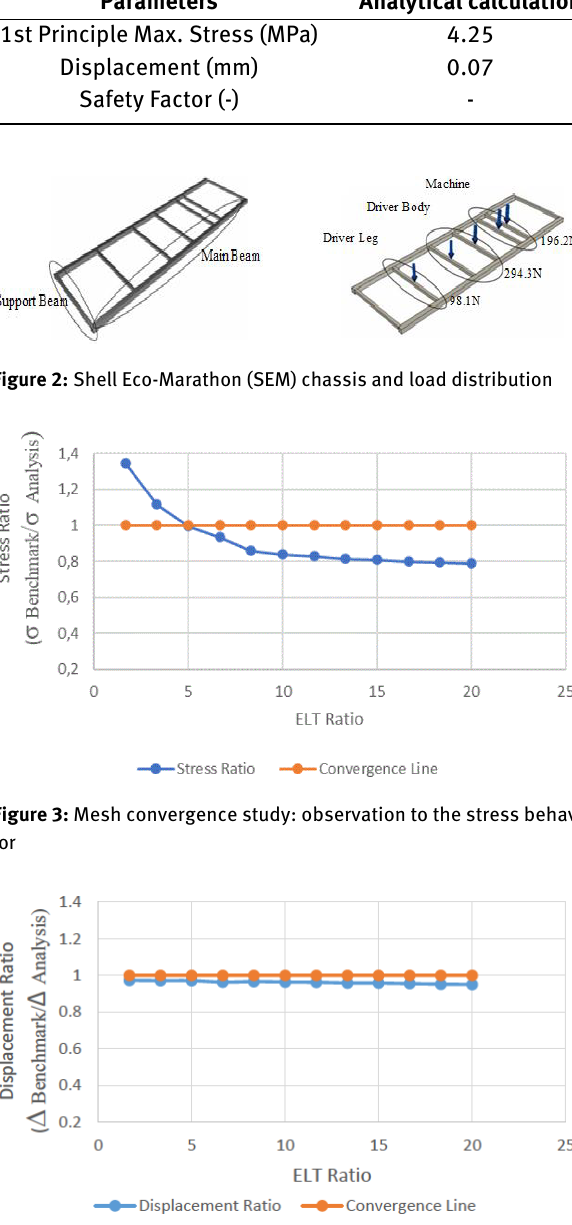
Figure 4: Mesh convergence study: observation to the displacement behavior